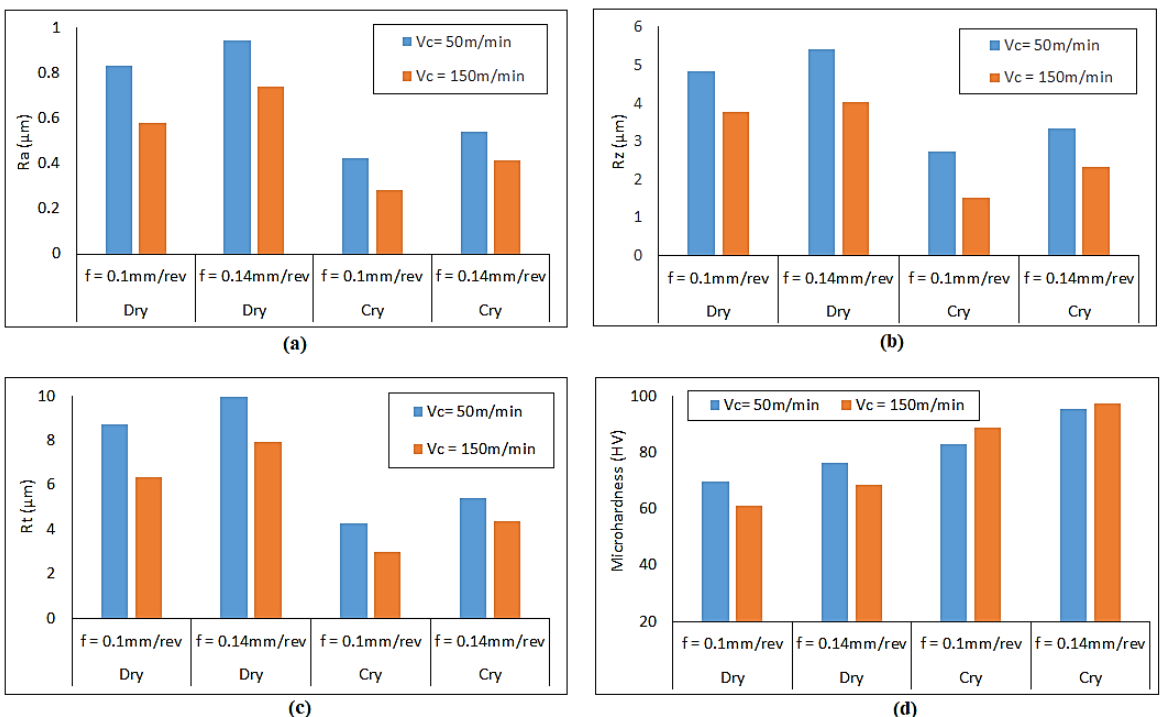
Figure 6. Variation of different responses with cutting parameters and conditions: ( a ) Ra; ( b ) Rz; ( c ) Rt; and ( d ) micro- hardness (µH).